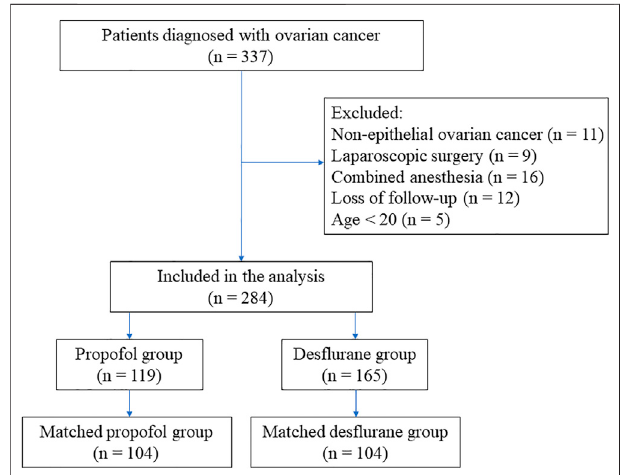
FIGURE 1 | Flow diagram detailing the selection of patients included in the retrospective analysis. Of the patients, 53 were excluded because of combined propofol anesthesia with inhalation anesthesia or regional analgesia,non-epithelialovariancancer,incompletedata,age < 20 years old, or undergoing laparoscopic